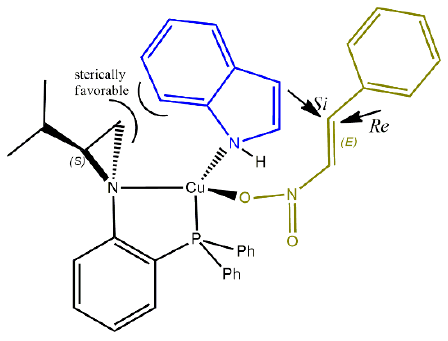
Figure 2. Tentative transition state model.